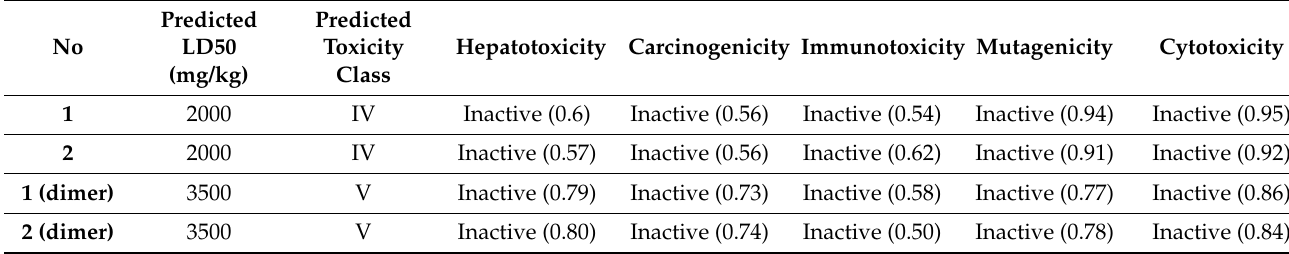
Table 6. Prediction of